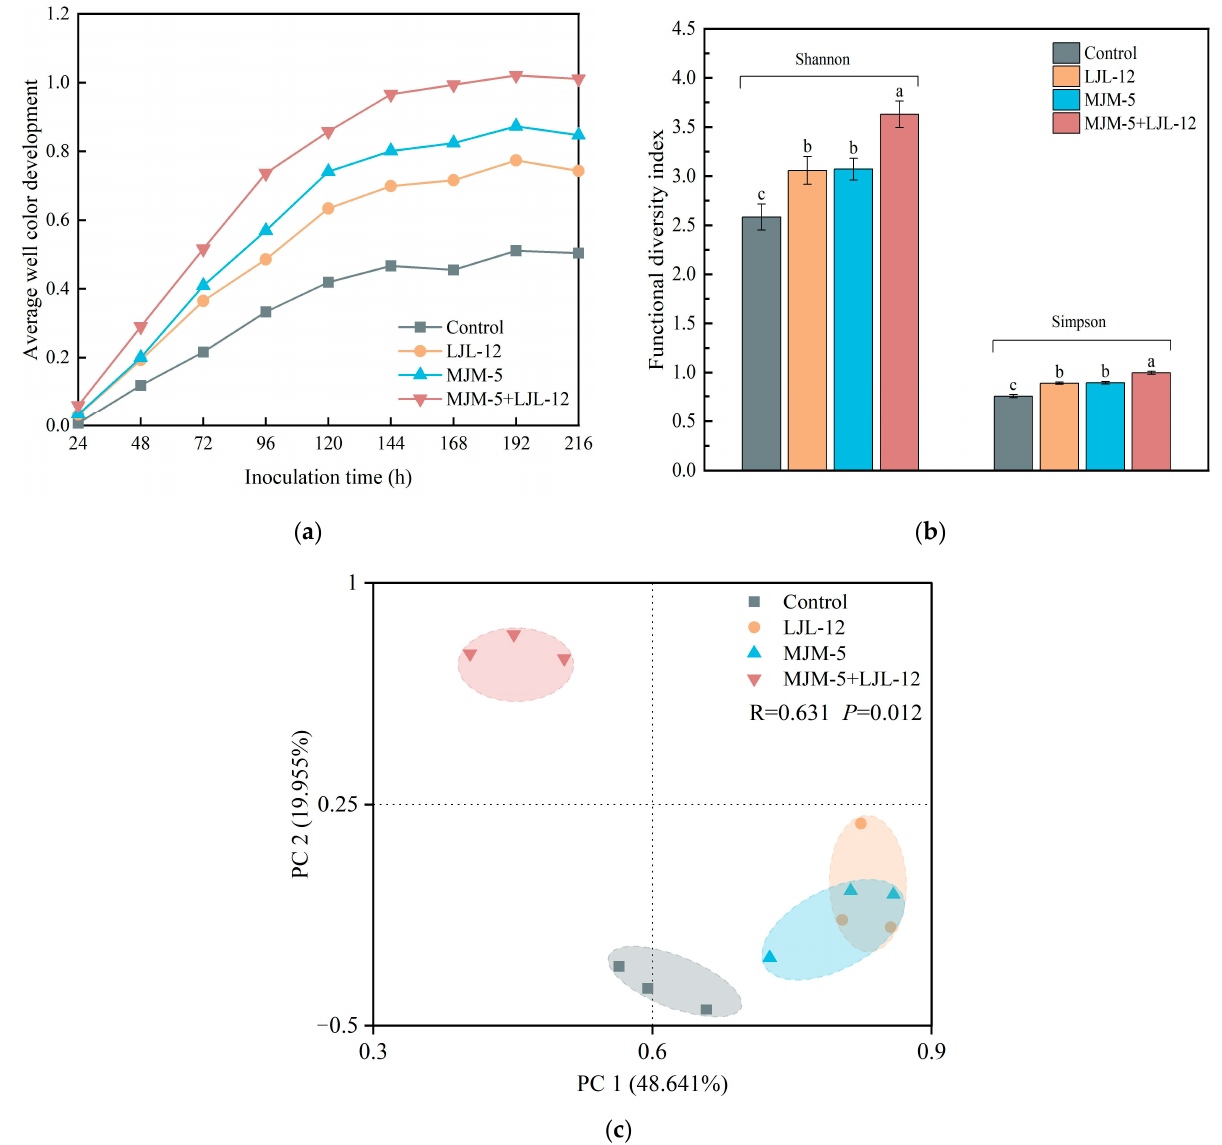
Figure 1. Microbial metabolic activity on carbon sources in the rhizosphere of alfalfa under Control, LJL-12, MJM-5, and MJM-5+LJL-12 treatments: ( a ) average well color development (AWCD); ( b ) functional diversity indices; ( c ) PCA of carbon source utilization. Lowercase letters indicate statistically significant differences among the treatments ( p < 0.05). The R and p values based on ADONIS indicate significant differences between the treatments.